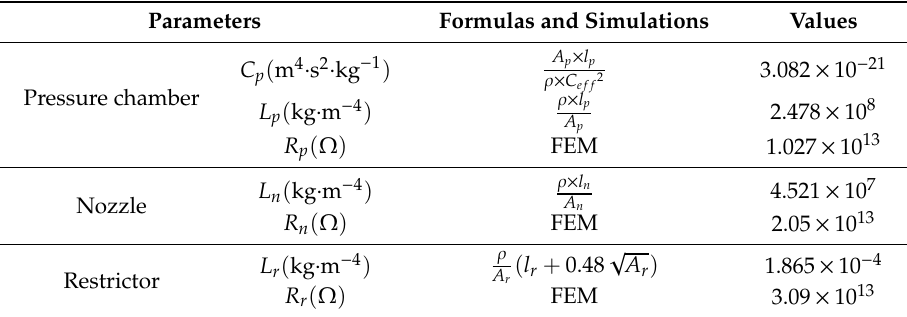
Table 3. Parameters used in lumped element modeling. FEM—finite element modeling.